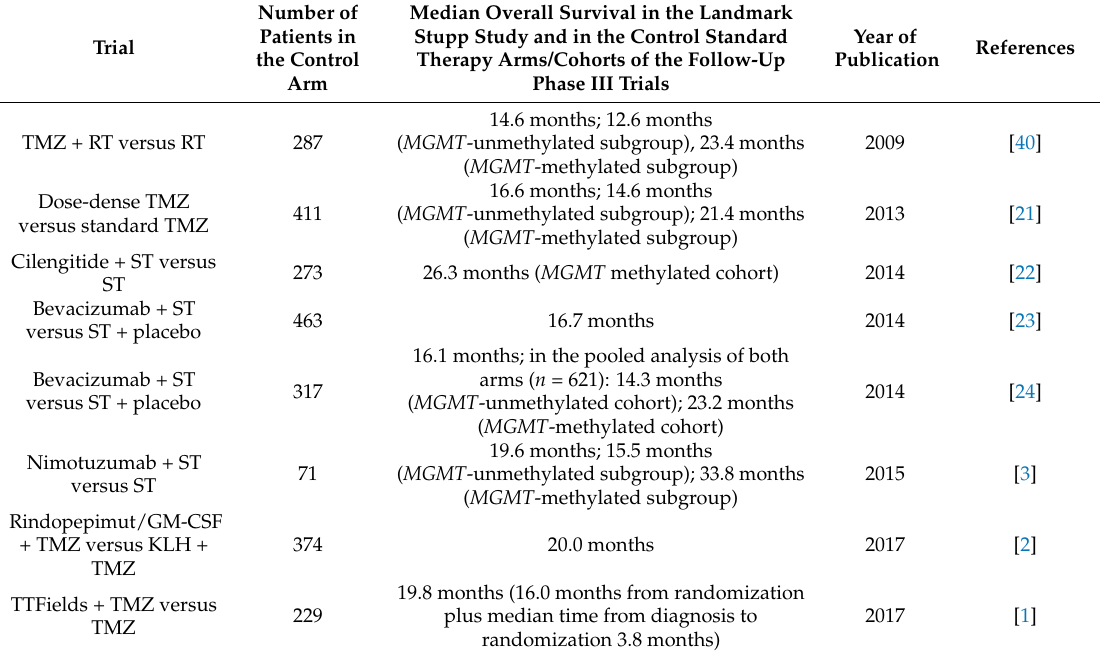
Table 1. A trending increase in median overall survival in the control cohorts/arms receiving standard therapy in phase III clinical trials. Median Overall Survival in the Landmark Stupp Study and in the Control Standard Therapy Arms/Cohorts of the Follow-Up Phase III